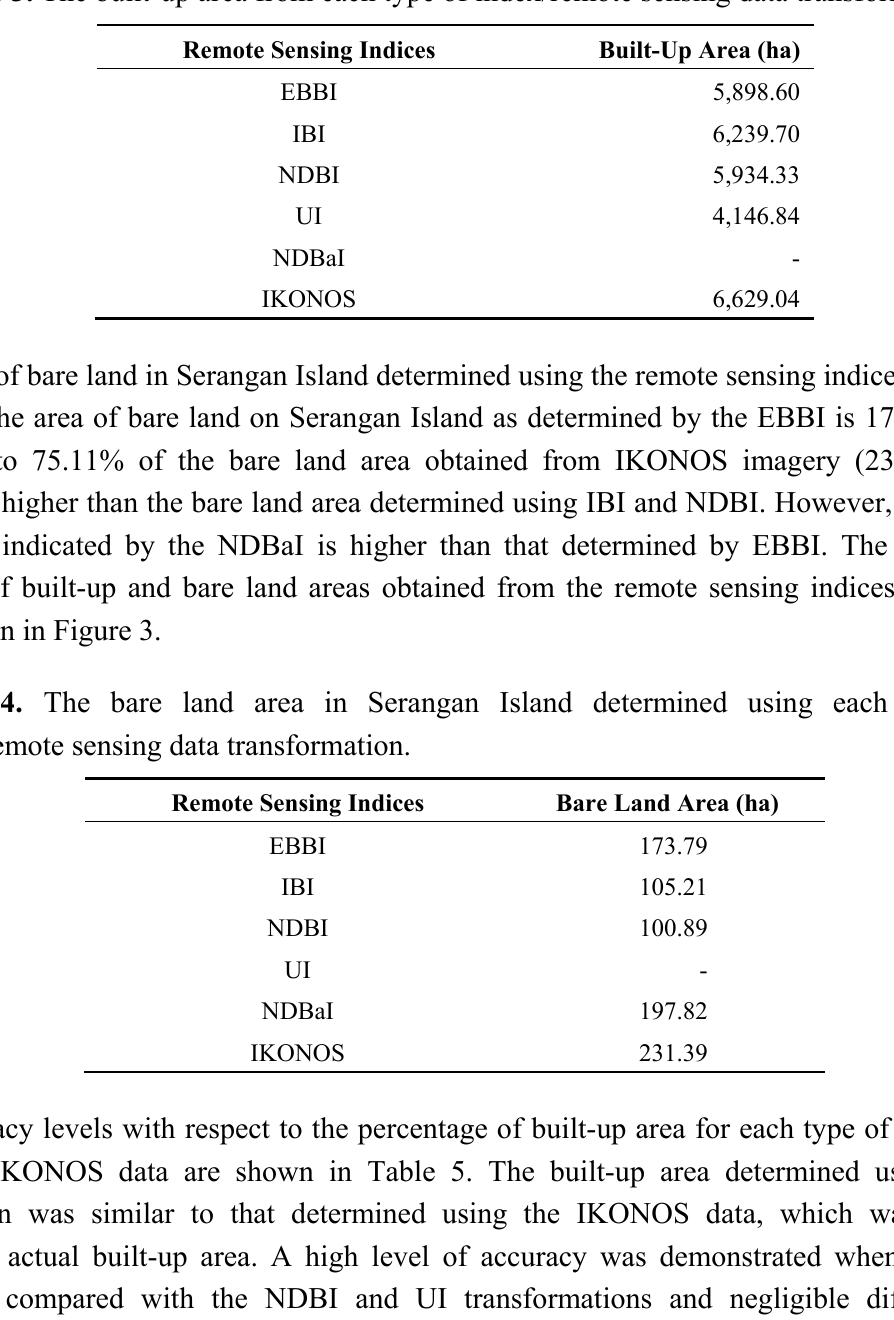
Table 3. The built-up area from each type of index/remote sensing data transformation.